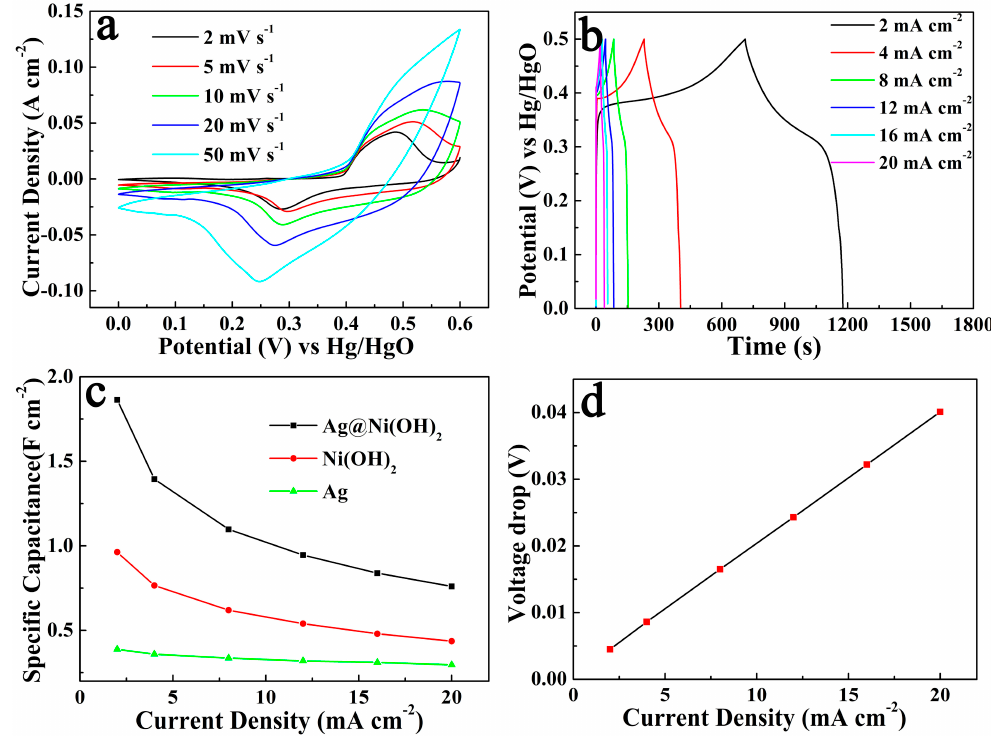
Figure 6. ( a ) The CV curves, ( b ) GCD curves, ( c ) plots of specific capacitance versus current density and ( d ) voltage drops during the GCD tests of the Ag@Ni(OH) 2 electrode.